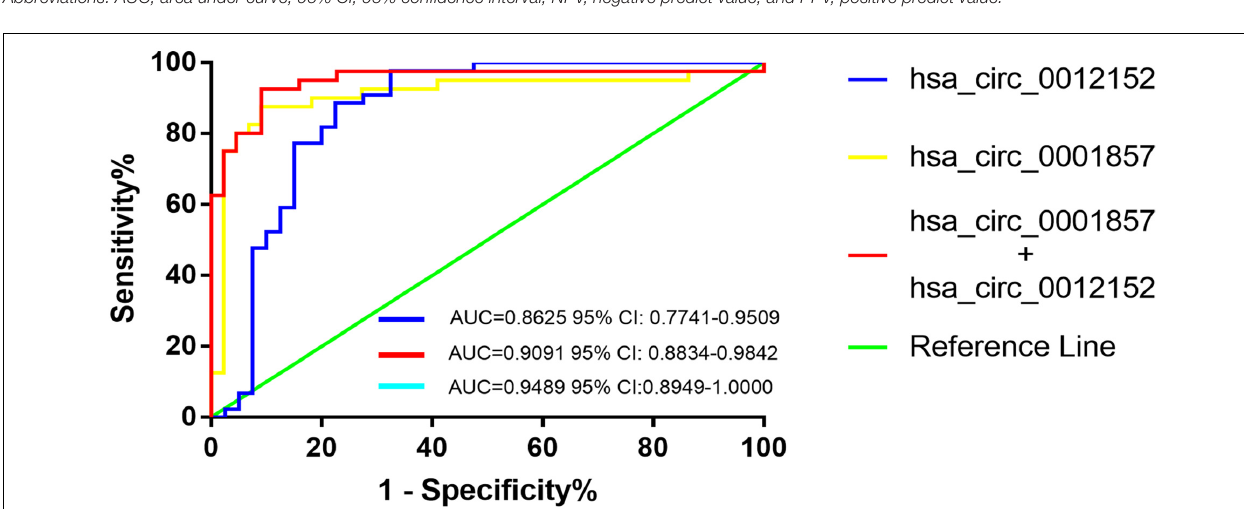
Frontiers in Oncology |